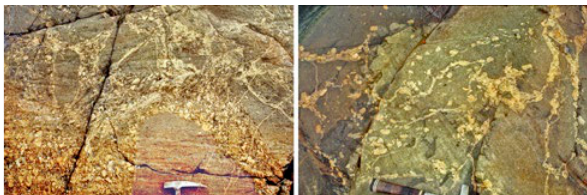
Figure 27. “We have every demonstration possible ... of the granite having been forced to flow ... among strata broken by a subterranean force and distorted in every manner and degree ...” These examples are from West Ava in the Åland Islands, Finland. The thin veins of granite and isolated globular feldspars are inconsistent with high temperature melting